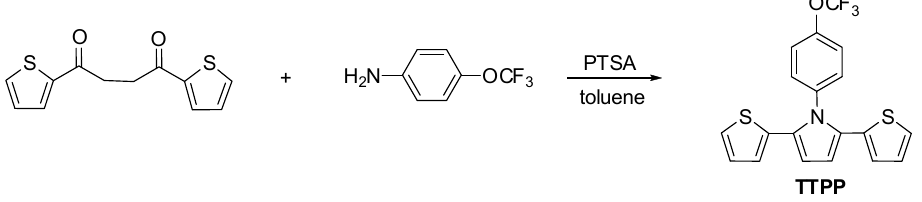
Figure 1. The synthetic scheme of 4 ‐ (trifluoromethoxy)phenyl ‐ containing SNS derivative.